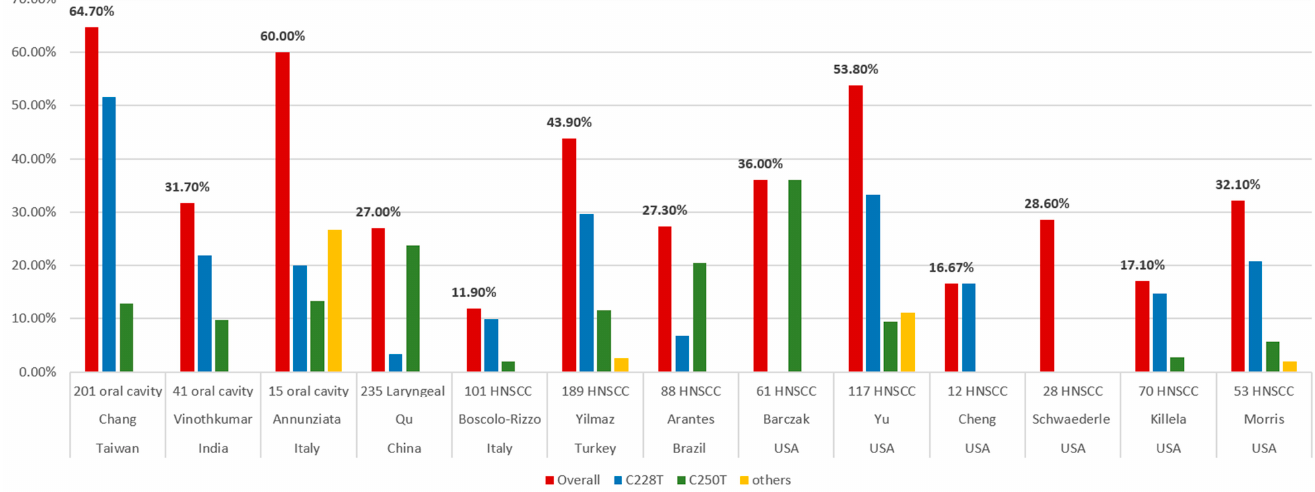
Figure 1. Frequencies of TERT promoter mutations in head and neck cancers from different